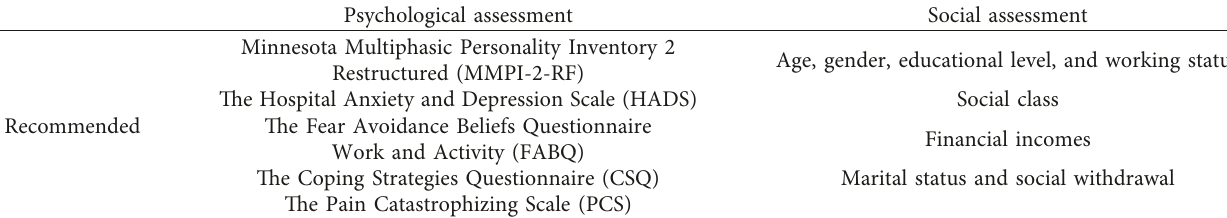
Table 3: Instruments to assess psychological and social well-being among patients with failed back surgery syndrome